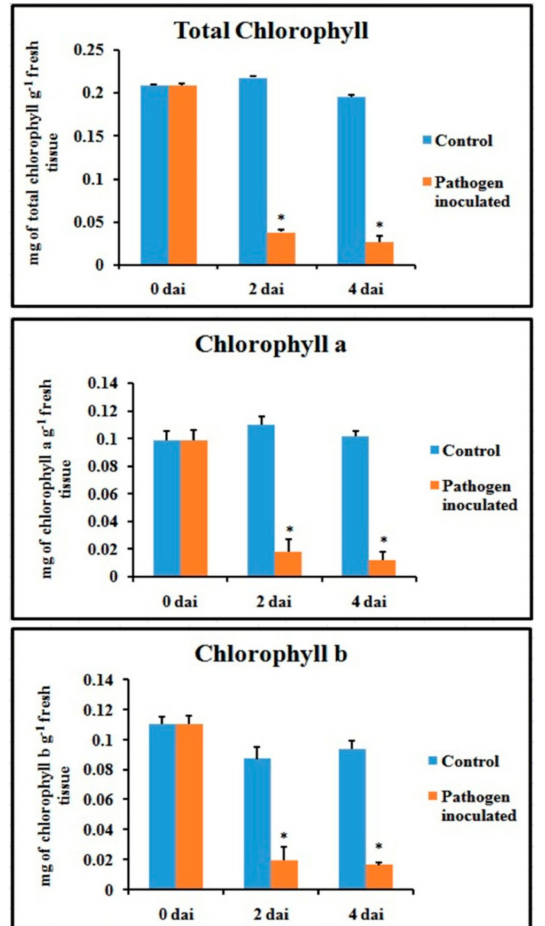
Figure 10. E ff ect of C. gloeosporioides on total chlorophyll content, chlorophyll a content, and chlorophyll b content in pathogen-inoculated bean leaves. Values represent mean ± SD of three separate experiments, each in triplicate. * Significant di ff erence between pathogen-inoculated and control sets at P < 0.05